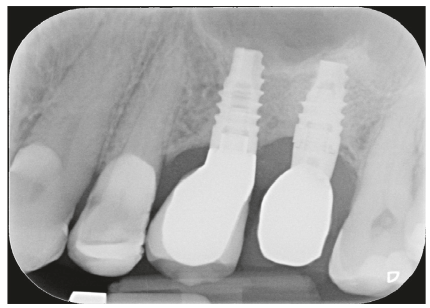
Figure 5: After 6 months, the mesial implant was uncovered, and a short implant was positioned in the molar site with an ulterior crestal sinus floor elevation. Note the new sinus floor level on the apex of the implant #25 and the displacement of collagen and basal bone on the top of the distal fixture.